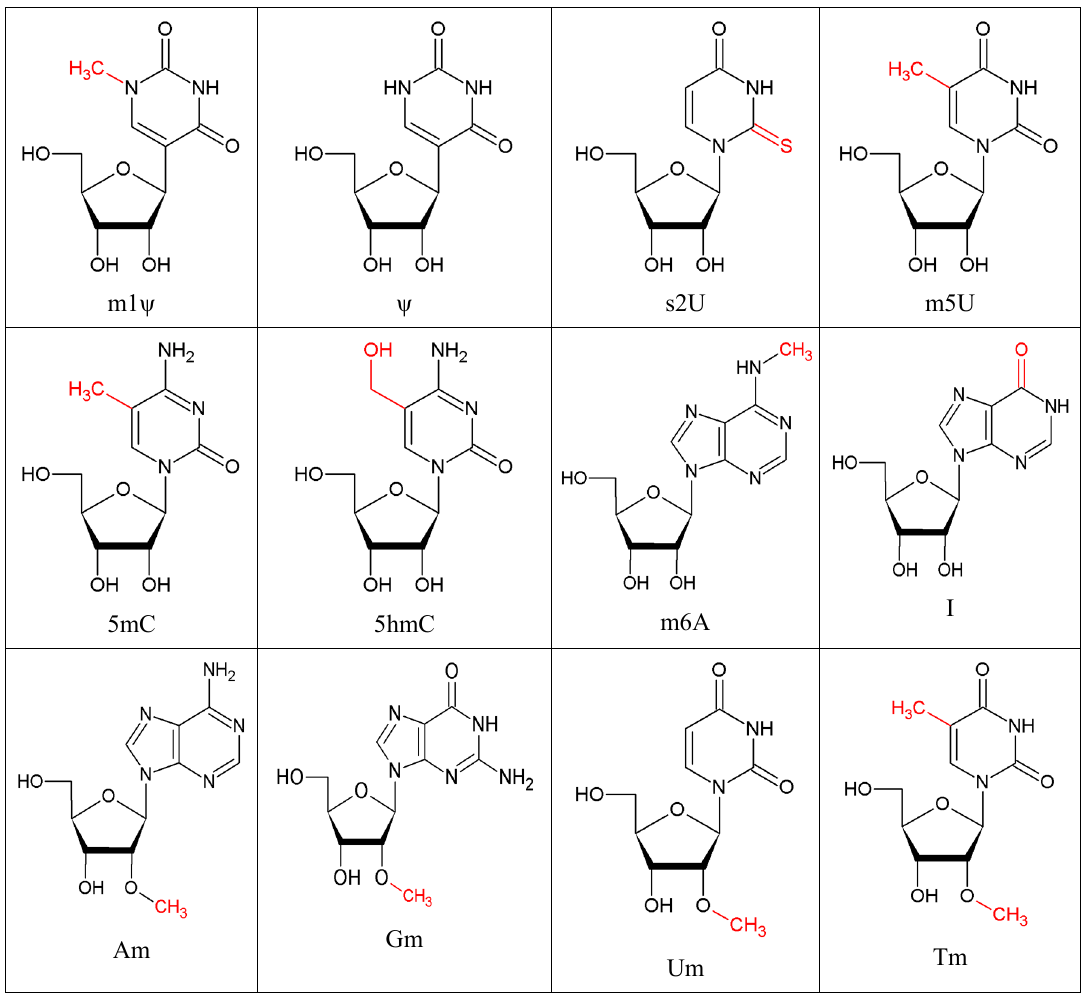
Figure 1. Selected RNA modifications with immune-modulatory properties Structures correspond to Table 1 and refer to [91] 2’- O -methylation of RNA in a physiological sequence context. Preferential recognition of RNA is based on sequence composition and RNA modifications.